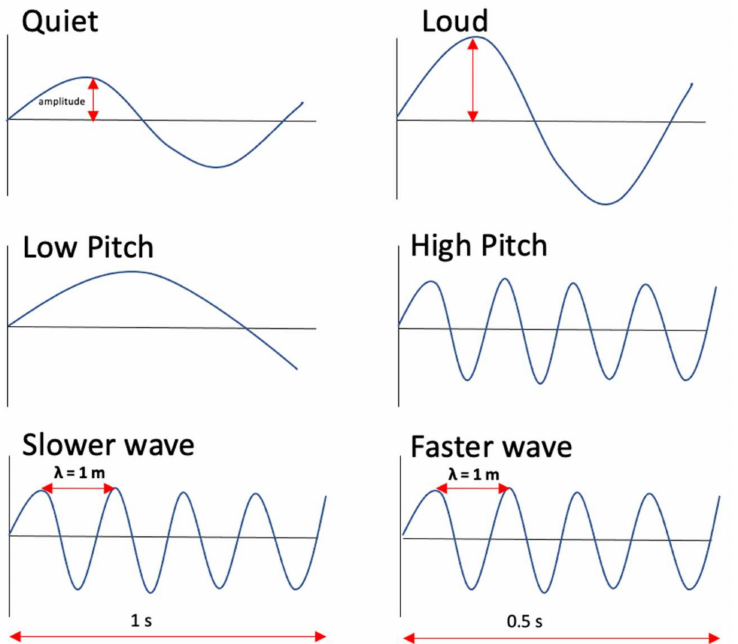
Figure 6. The variable properties of a soundwave. Amplitude is the maximum distance of displace- ment for a vibrating particle from its mean position, so as amplitude increases the volume of a sound increases ( top row ); as frequency increases so does pitch ( middle row ). Velocity is a measure of distance over a period of time (m/s), whereas acceleration is the change in velocity over a time period (m/s 2 ). In the bottom row , the velocity of the left wave is 4 m/s, whereas the velocity of the right wave is 8 m/s. The change in speed to transition from the left to right wave would require an increase in